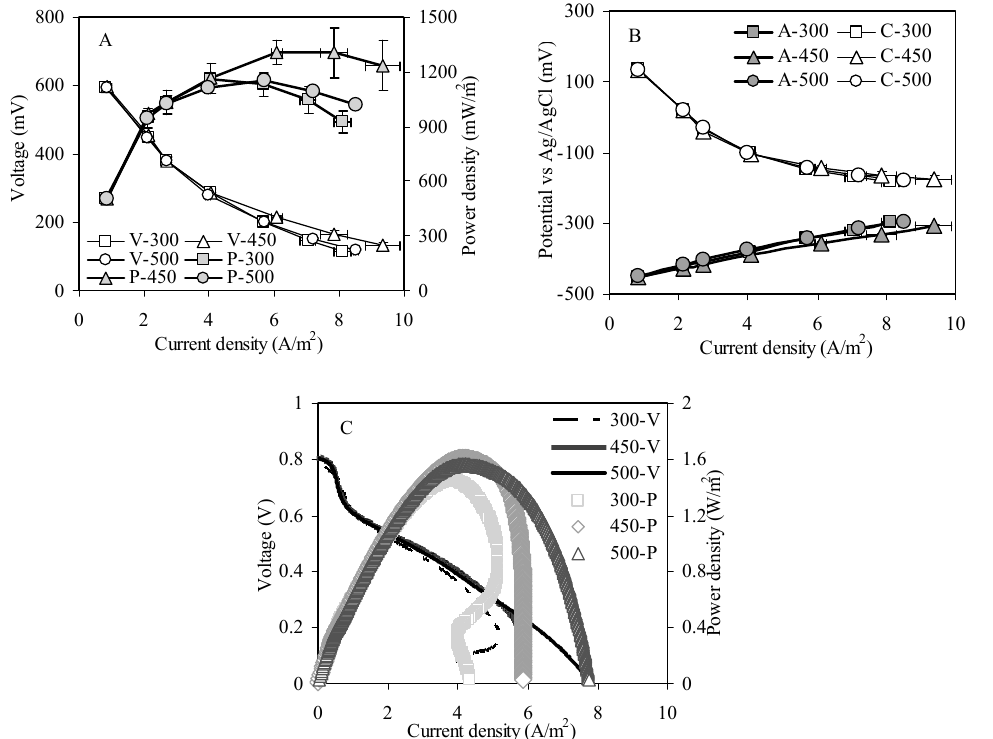
Figure 1. Power density ( A ) and electrode potential ( B ) curves for MFCs with different temperature treatment anodes by variable external resistances method and power curves by LSV ( C ).